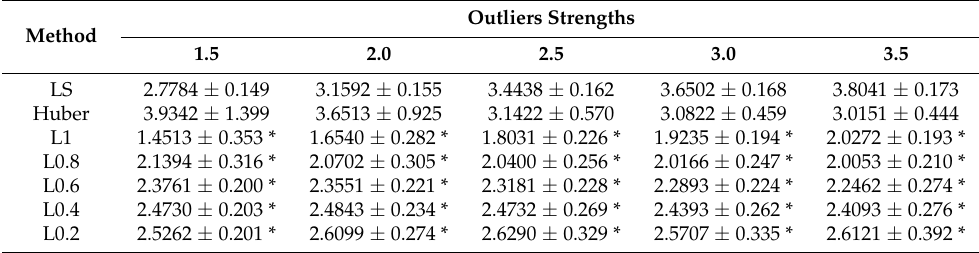
Table 6. Fitting errors of the SISO system with different outlier strengths.